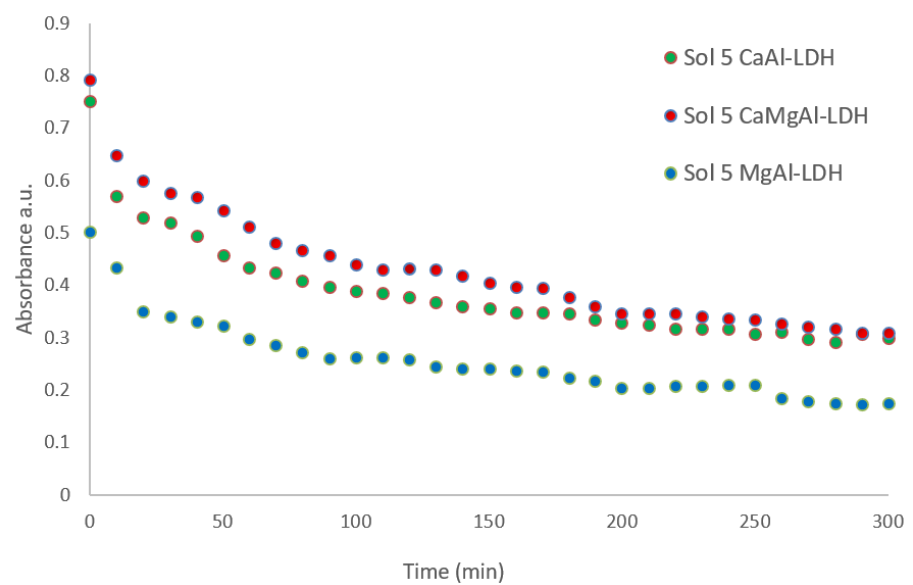
Figure 4. The kinetic stability of consolidants at water/ethanol ratio of 6/4 (vol).